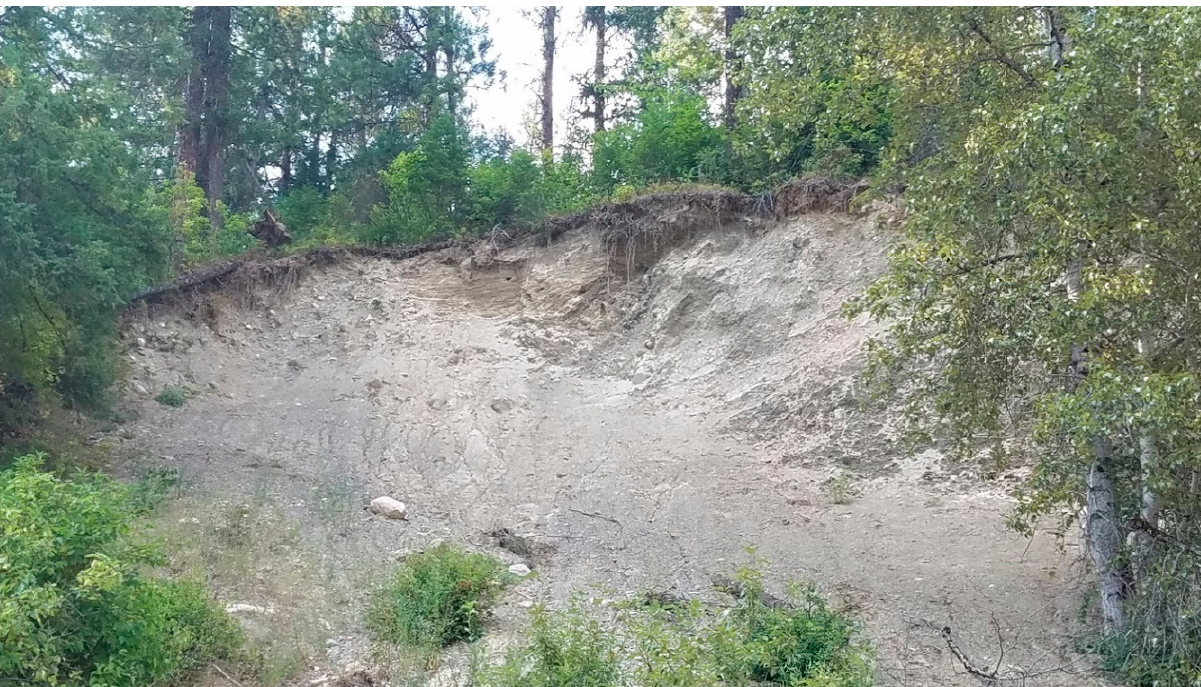
Figure 6. A source area of a landslide in forested terrain, Washington state. Note the exposed shallow root system as well as vegetation colonizing the lower portion of the scar.